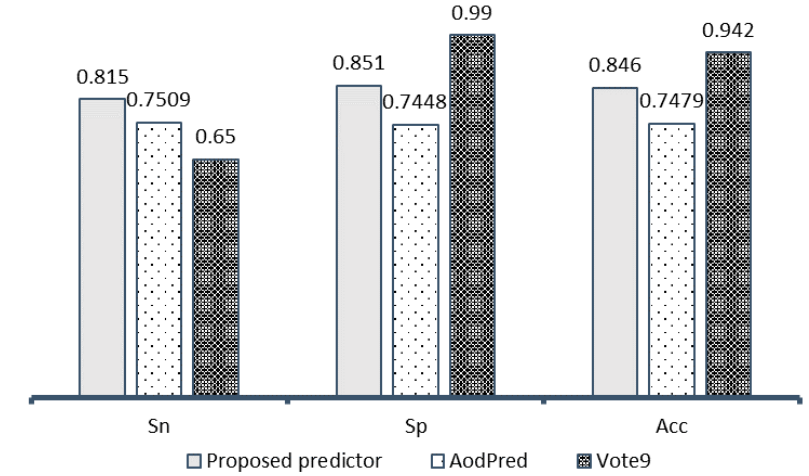
Figure 4. Comparison with existing models on cross-validation.